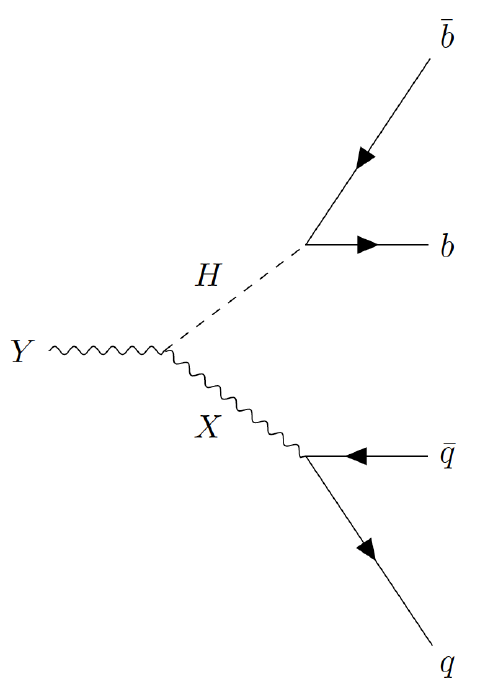
Figure 1. Feynman diagram of the target signal process, where the Y is produced in the initial pp collision and decays to a fully hadronic final state via an SM Higgs boson( → b ¯ b ) and a new particle X. Because H and X masses are of the order of thousands of GeV, they are created with a significant momentum component in the transverse plane with respect to the beam axis, labeled p T , that increases with the mass of the resonance. This collimates each boson’s decay products, which are then reconstructed together as a single jet with a large radius, from now on, identified by J. Therefore, the signature of such a signal is a resonant structure in the dijet invariant mass spectrum, where events can be selected based on a final state of two large-radius jets. A supplementary resolved selection is used to reconstruct the X mass with small-R jets (in this paper labeled with j) in the case of insufficient boost from the Y. The primary background comprises SM multi-jet processes, where jets are produced from quantum chromodynamic [9] (QCD) interactions, producing a smoothly falling in- variant mass distribution on top of which a signal bump can be